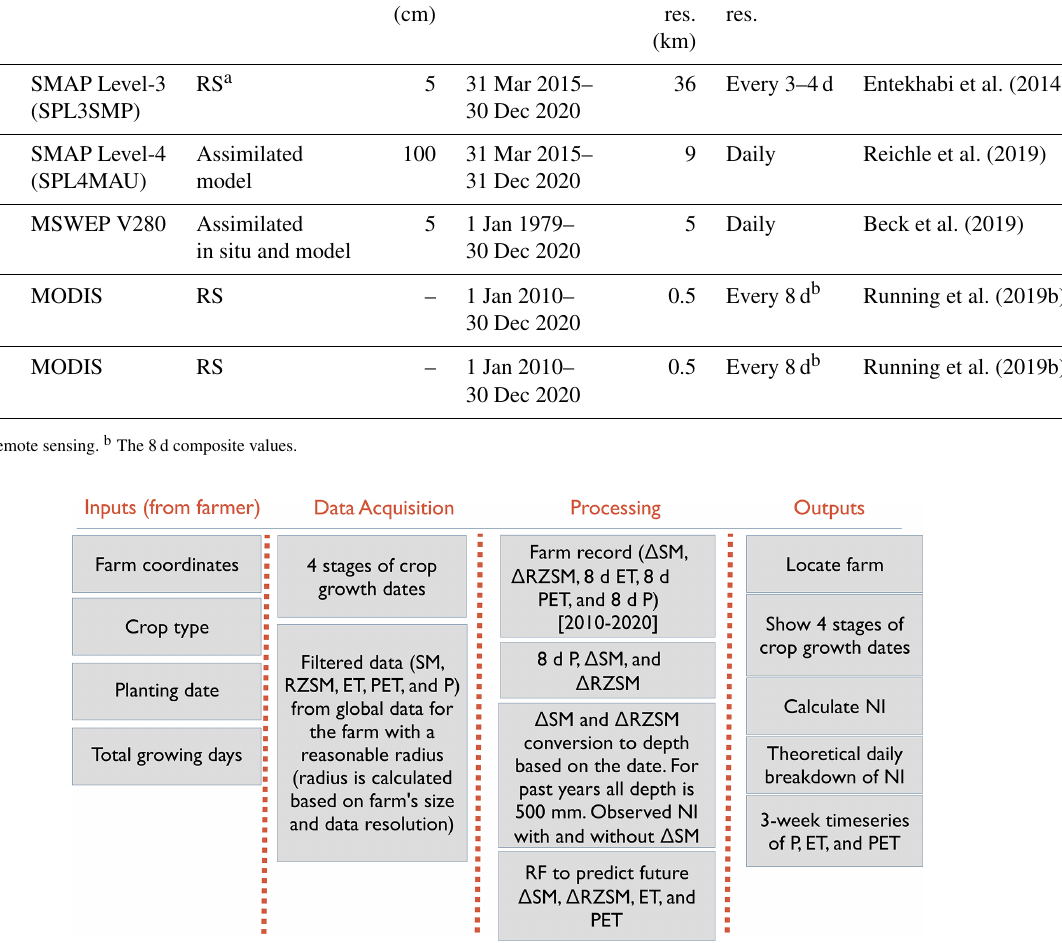
Table 3. Datasets and the periods used to train and run the model in this study. All input variables were clipped to the CPE domain. Variable